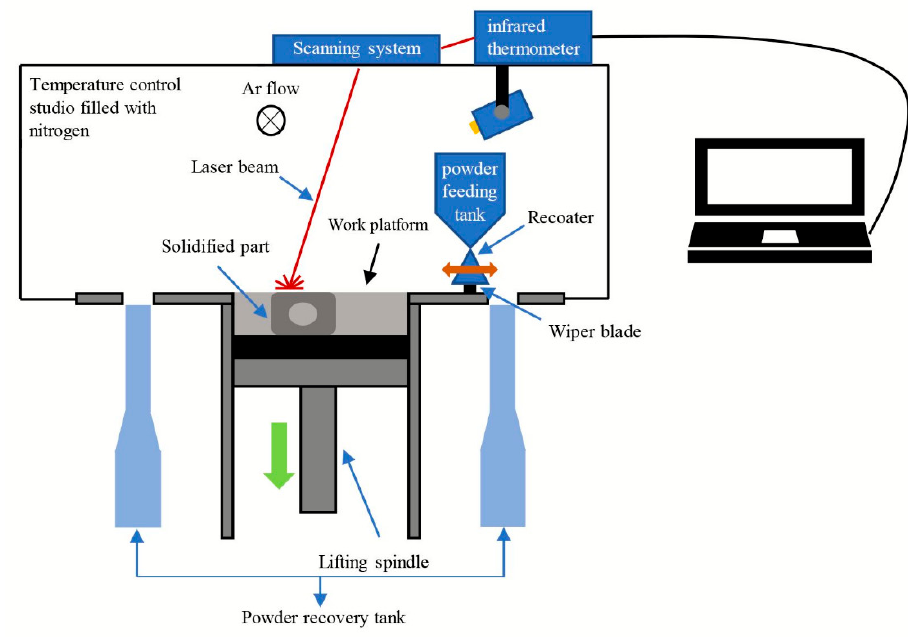
Figure 2. SLM technology molding schematic.